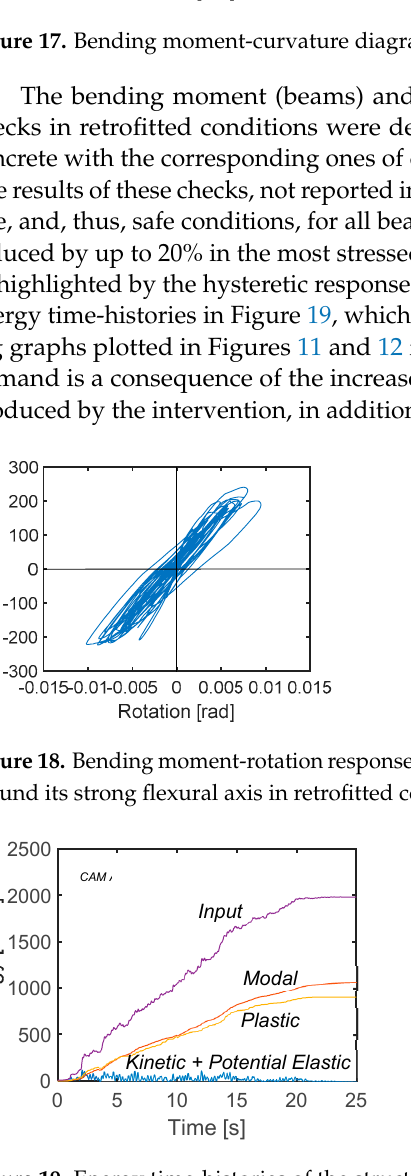
Figure 19. Energy time-histories of the structure in retrofitted conditions.